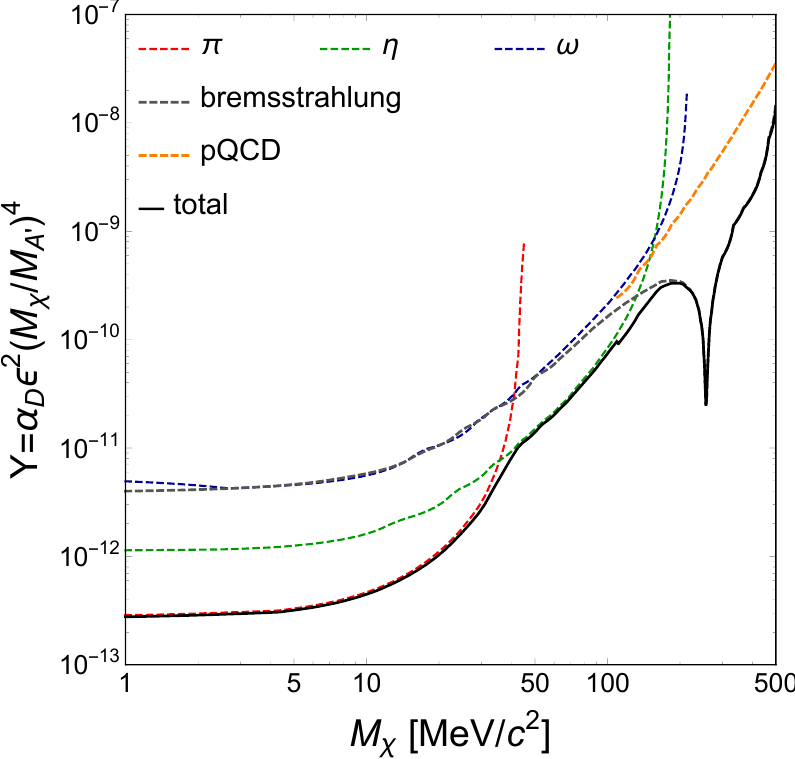
Figure 13. SHiP SND exclusion limit at 90% CL relative to a A 0 decaying into χ ¯ χ pairs for the benchmark point α = 0 . 1 and m = 3 m . The contributions from the different production D A 0 χ mechanisms are reported